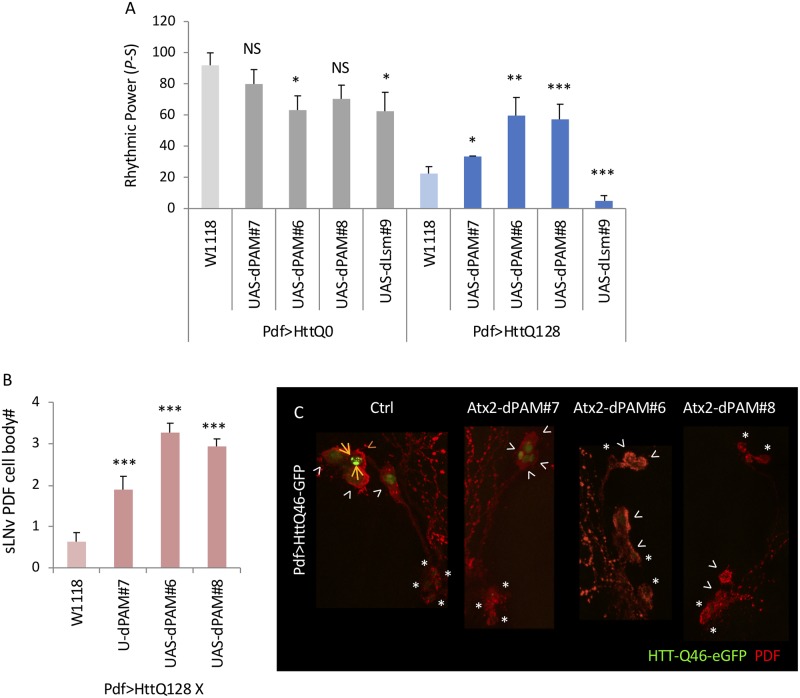
ATX2 lacking the PABP-binding (PAM2) domain reduces mHtt toxicity while Atx2 lacking the Lsm domain does not.A. Rhythmic power (P-S) is indicated for various genotypes including flies expressing three independent overexpression line of ATX2 lacking PAM2 domain and one overexpression line of ATX2 lacking Lsm domain in PDF neurons (Atx2-dPAM#7/6/8 and Atx2-dLsm#9) together with HttQ0 (Pdf>HttQ0; n = 12–39) or HttQ128 (Pdf>HttQ128; n = 7–44; *:p<0.05, **p<0.01, ***:p<0.005, error bars represent standard error) is shown. B. The number of sLNv present per brain hemisphere at day 10 is indicated for various genotypes where either ATX2 lacking PAM2 domain (Atx2-dPAM#6/7/8) or wild-type control (Ctrl) together with HttQ128 are expressed in PDF neurons is shown (n = 15–19; *p<0.05, **p<0.01, ***:p<0.005, error bars represent standard error). C. Representative images of sLNv and lLNv expressing HttQ46-eGFP at age day 30 are shown in the wild-type control background (Ctrl) or with ATX2-dPAM overexpression (Atx2-dPAM#6/7/8). White arrowheads indicate lLNvs without aggregates while orange arrow head indicates lLNvs with aggregates. Asterisks label sLNvs. Example aggregates are pointed out by orange arrows.